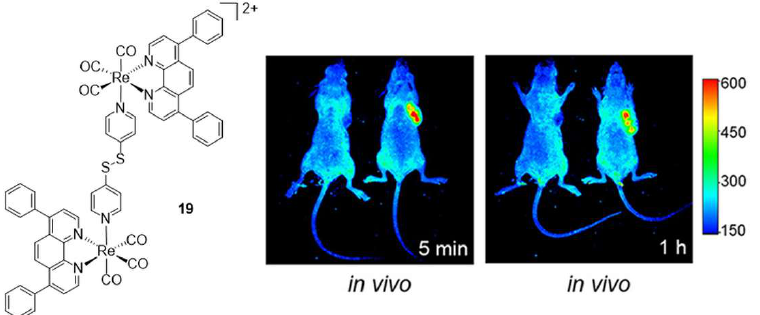
Figure 2. Structure of 19 and in vivo fluorescence emission of the compound after intratumoral injection in a mouse xenograft model (1 mg/kg, right mouse in both panels). The molecule was dissolved in 6% polyethylene glycol 400, 3% ethanol, and 1% Tween 80 in phosphate-buffered saline (PBS). The excitation wavelength is 430 nm, and the maximum emission wavelength is 600 nm. Color scale refers to emission intensity (a.u.). Figure readapted with permission from publisher [36] . Higher-order homonuclear multimetallic fac -[Re(CO) 3 ] + complexes have been pre- pared by Gianferrara, Gasser, and Vilar [38] and the Smith group [39]. The former authors described phototoxic neutral fourfold-symmetric porphyrins derivatized with four [1,4,7]- triazacyclononane rhenium complexes connected to the porphyrin macrocycle through